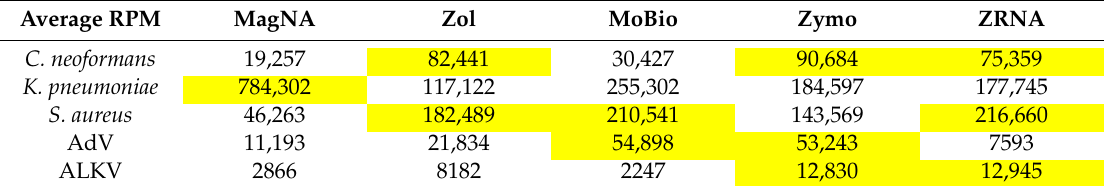
Table 2. Average reads per million (RPM) from RNA sequencing for the pathogens included in the mock sample using di ff erent